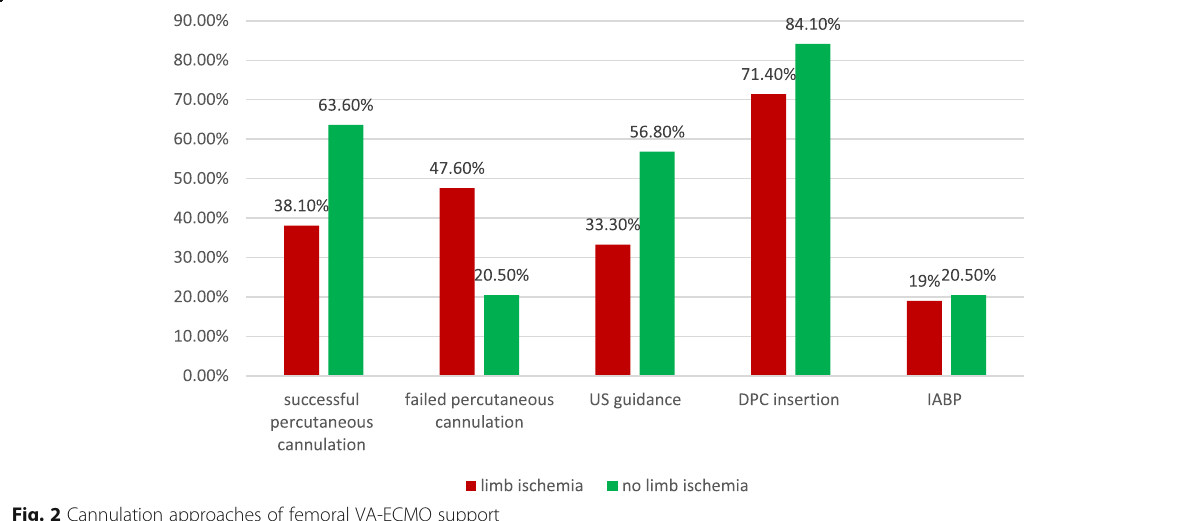
Fig. 2 Cannulation approaches of femoral VA-ECMO